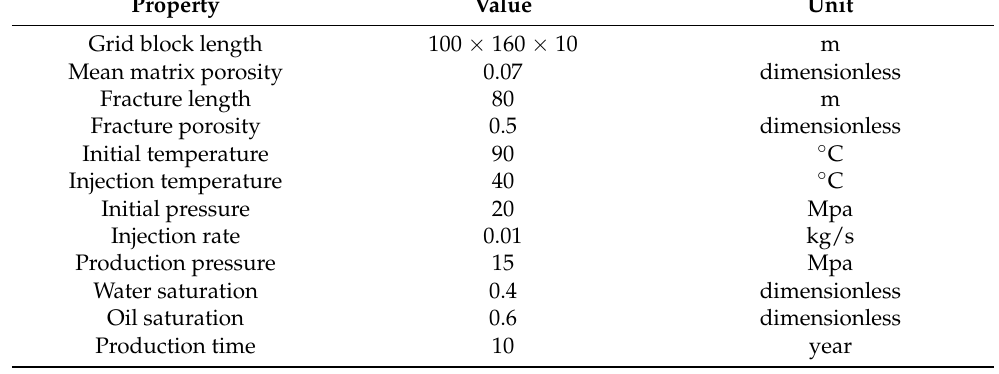
Table 4. Basic parameters data of simulation model.